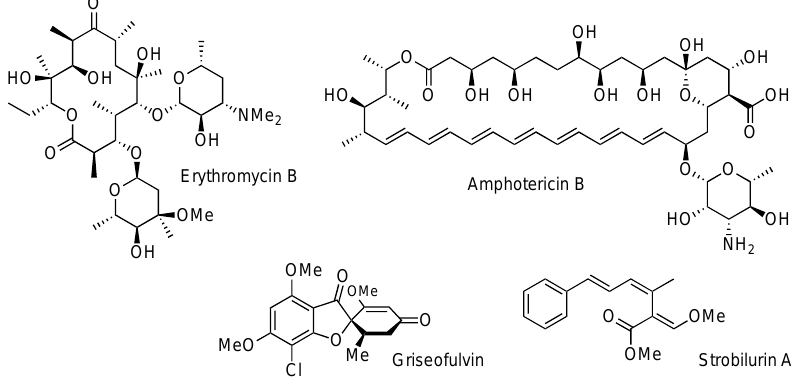
Figure 1. Examples of bioactive polyketide natural products from bacteria and fungi.